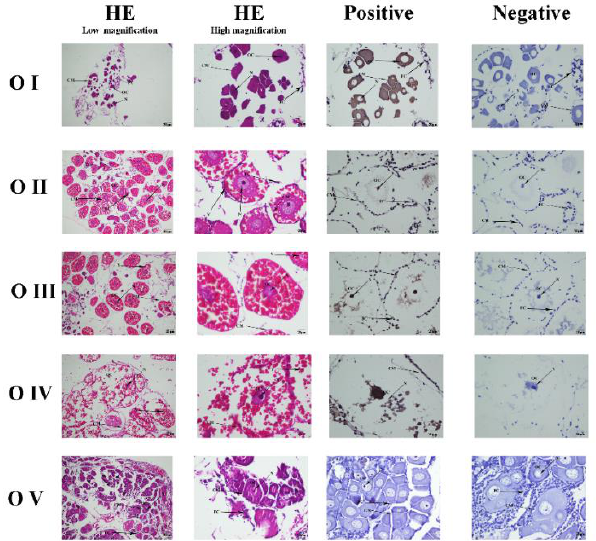
Figure 5. Representative histological sections showing Mn-CTSD expression during different ovarian maturational